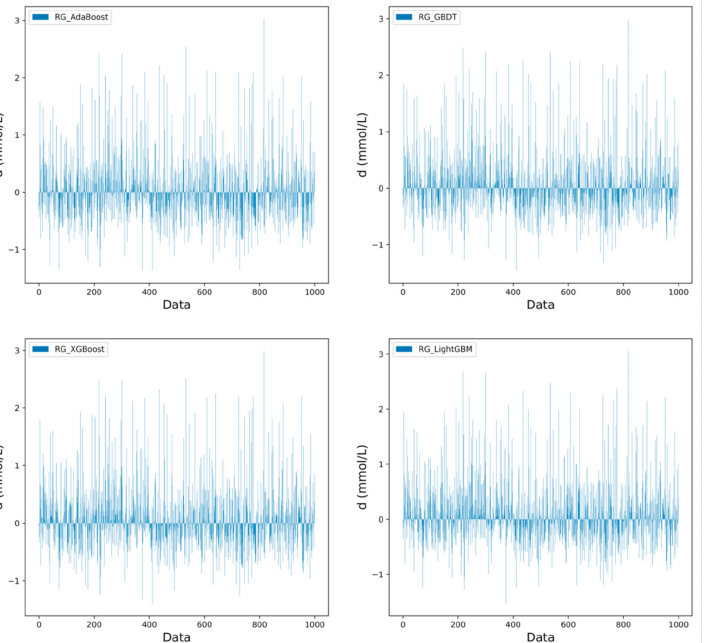
Figure 7. The difference ( d ) between the predicted and actual blood glucose (fasting/pre-prandial) levels for the RG-enriched